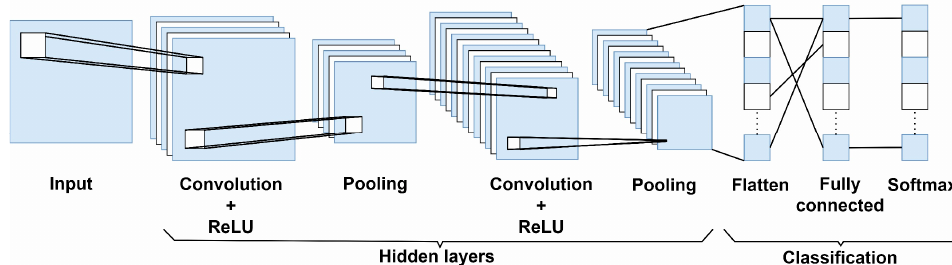
Figure 1. Convolutional neural network architecture.